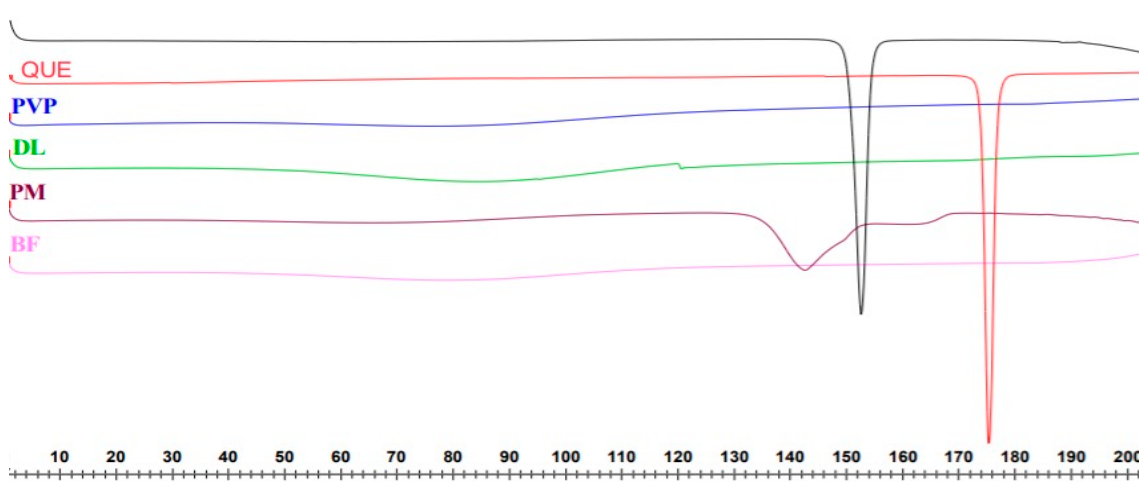
Figure 3. DSC data for ESC, QUE, PVP, physical mixture (PM), drug-loaded fibers (DL), and blank fibers (BF), indicating the melting temperatures of ESC and QUE at 154.3 and 176.8 °C, respectively. DL fibers exhibited no drug endothermic peaks that indicated the molecular dispersion transformation of the drugs within these fibers.